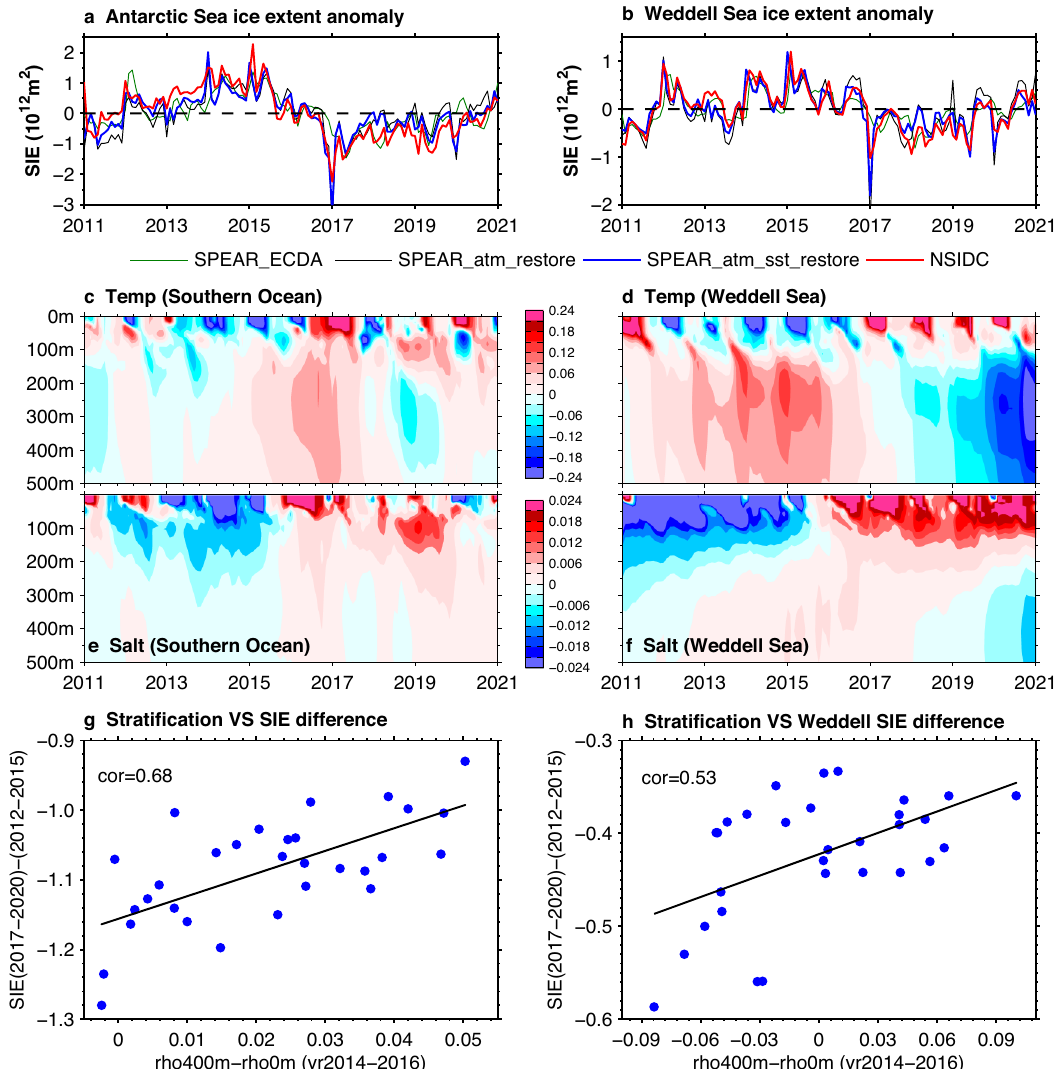
Fig. 2 Ocean changes associated with the Antarctic Sea ice extent (SIE) shift. a Monthly mean SIE anomaly in National Snow and Ice Data Center (NSIDC) observation (red line), SPEAR_ECDA (green line), SPEAR_atm_restore (black line), and SPEAR_atm_sst_restore (blue line). c Time-depth evolutions of the monthly Southern Ocean (SO) area averaged (60°S – 70°S, 0°E – 360°E) temperature anomalies in SPEAR_atm_sst_restore. e Same as ( c ) but for the salinity anomalies. g Scatter plot of the SO ocean strati fi cation (de fi ned as the density difference between 400 m and 0 m) averaged in time period 2014 – 2016 versus the Antarctic SIE difference (between 2017 – 2020 and 2012 – 2015). ( b ), ( d ), ( f ), and ( h ) are the same as ( a ), ( c ), ( e ), and ( g ) but for the Weddell Sea (55°S – 74°S, 50°W – 10°E). All anomalies are with respect to the 2011 – 2020 climatology. Units for the SIE, ocean temperature, salinity, and density are 10 12 m 2 , °C, PSU, and kgm − 3 , low SIE in SPEAR_atm_restore. This enhances our argument in sea ice states to average level. We also see that none of the the last section that the subsurface SO prior to 2016 contributes hindcasts produced the record-breaking SIE decline in late 2016 very little to the sea ice extreme event in late 2016, and that this (Fig. 4a). The hindcast initialized on 1 January 2016 only produces event was essentially driven by the atmospheric forcing. a very small SIE low in late 2016, which accounts for ~10% of the Figure 2g, h and the sensitivity experiment (SPEAR_atm_res- record low SIE. The hindcasts initialized in 2015 and 2014 have tore_2015_newIC) also indicate a potential predictability of the even less skill in predicting the 2016 extreme event. These recent SIE shift since they relate the current ocean state to the future sea ice evolutions. This motivates us to investigate our decadal hindcasts/forecasts that are initialized from SPEAR_- atm_sst_restore on January 1 every year (see “ Methods ” for more model details). Figure 4a, b displays the decadal prediction initialized in 2014, 2015, and 2016 for the total Antarctic SIE and Weddell SIE, respectively, along with the ice time series in observation and SPEAR_atm_sst_restore. All hindcasts produce small SIE values after 2016. The hindcasts initialized in 2014 and 2015 capture a large part of the recent SIE shift, moving the high